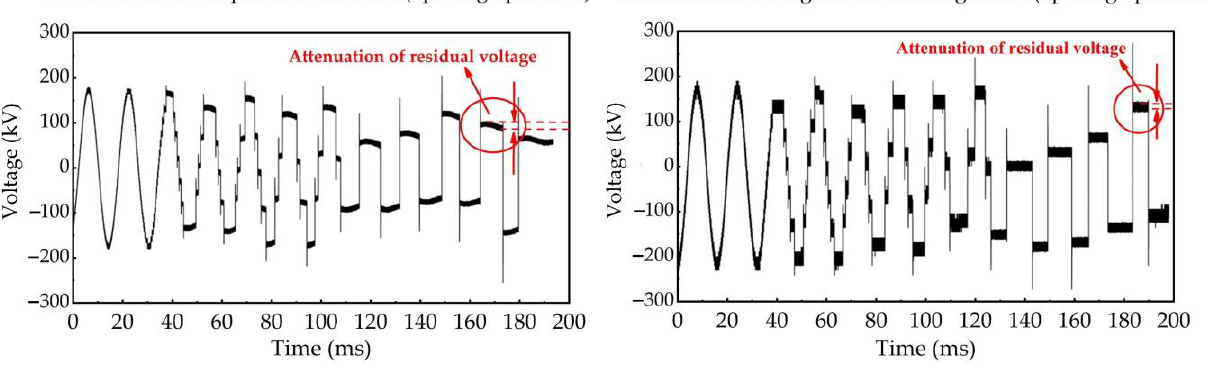
Figure 13. The typical full-time waveform of VFTO measured by the new signal conditioning sensor and the old impedance converter during closing operation. As shown in Figure 12, the VFTO waveform on the load side of GIS is composed of a 50 Hz power frequency sine wave, dozens of step waves and high-frequency oscillation waves superimposed at the beginning of each step wave. The time interval between these high-frequency oscillation pulses shows the characteristics of being first dense and then sparse during the opening operation of disconnector. In the closing operation, it shows the opposite characteristics. Combined with the description in Section 2.2, the signal con- ditioning sensor is used to improve the low-frequency measurement performance of the capacitive voltage divider and optimize the high-frequency transient signal. Hence, the characteristics of the step waves and the fast high-frequency oscillation pulses in the VFTO measurement results are compared in our research, respectively. The step waves represent the quasi-DC components in the VFTO signal, which mainly reflects the variation characteristics of trapped charge in the no-load short busbar within the time interval between two adjacent high-frequency oscillation pulses. During this time, the voltage on the no-load short busbar consists of two parts: the power fre- quency voltage induced by the stray capacitance between disconnector gap, and the trapped charge voltage represented by the trapped charge in the no-load short busbar. Usually, the power-frequency-induced voltage is far less than the trapped charge voltage.